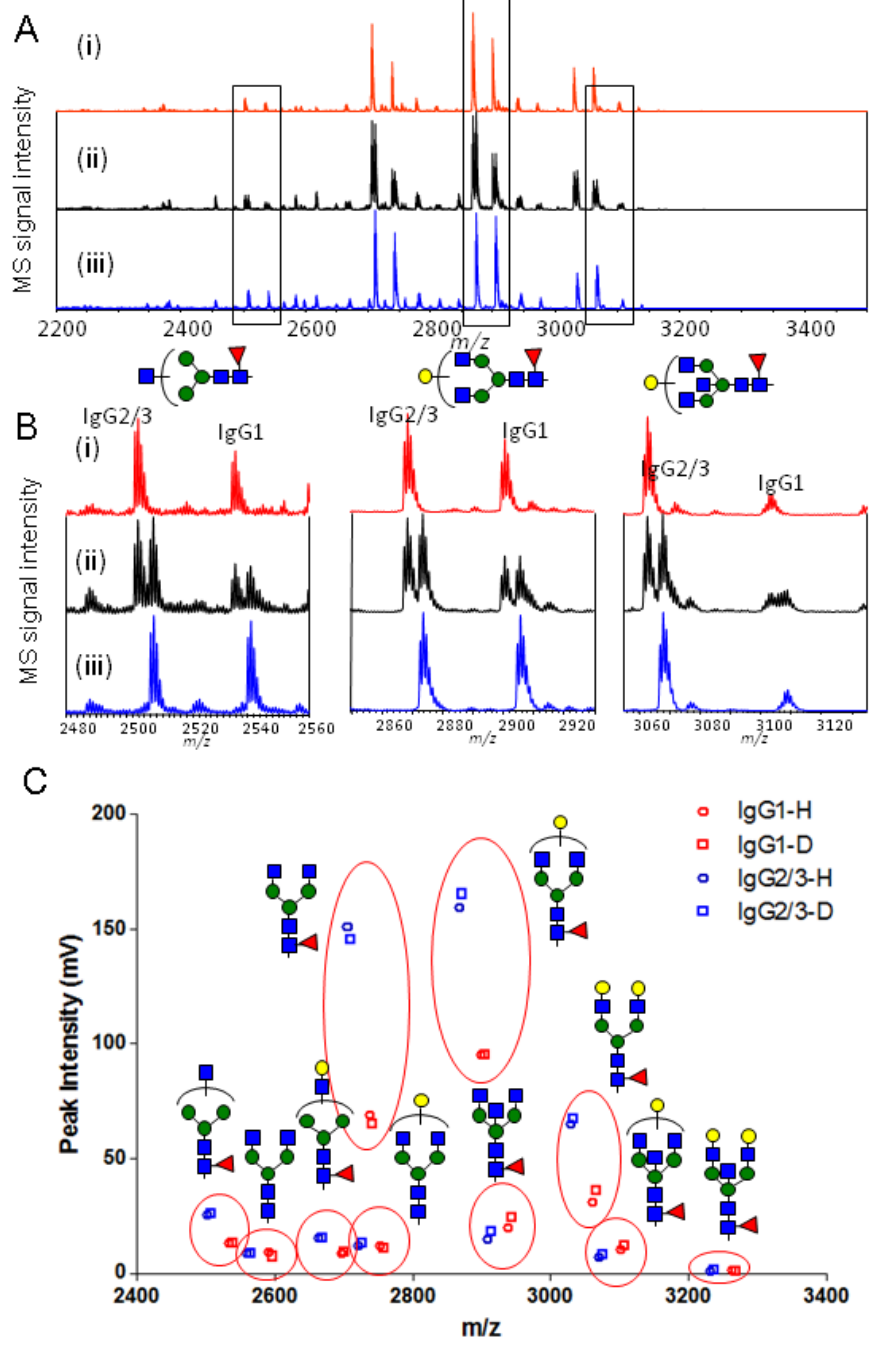
Figure 2. Validation of the proposed method using glycopeptides from human serum